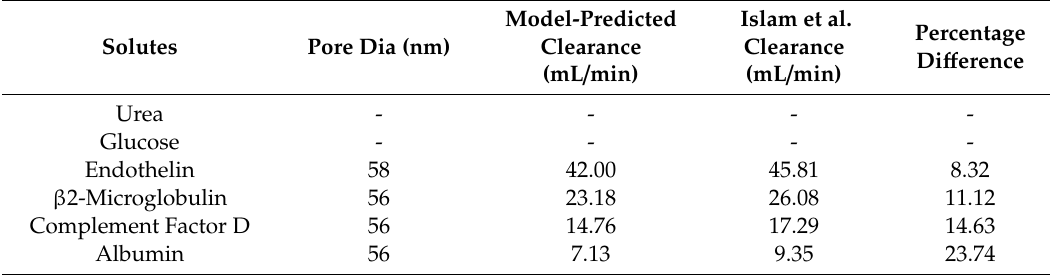
Table 9. Maximum percentage di ff erence of this model with literature data at a varying pore diameter of dialyzer fiber